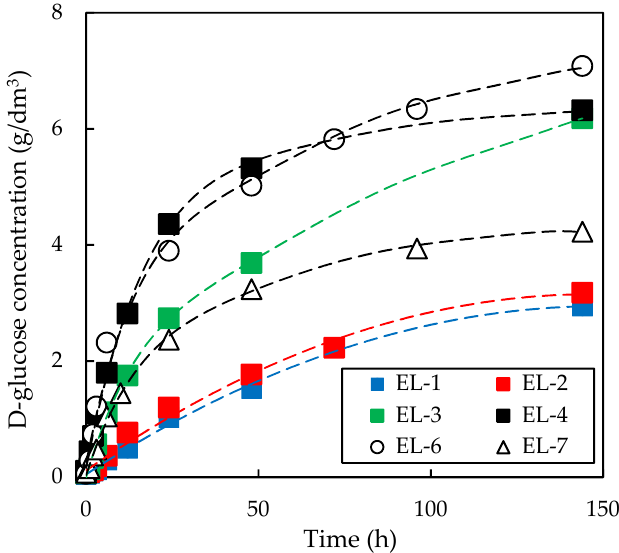
Figure 4. Evolution of D-glucose concentration over time for the enzymatic hydrolyses performed with different enzyme loadings.